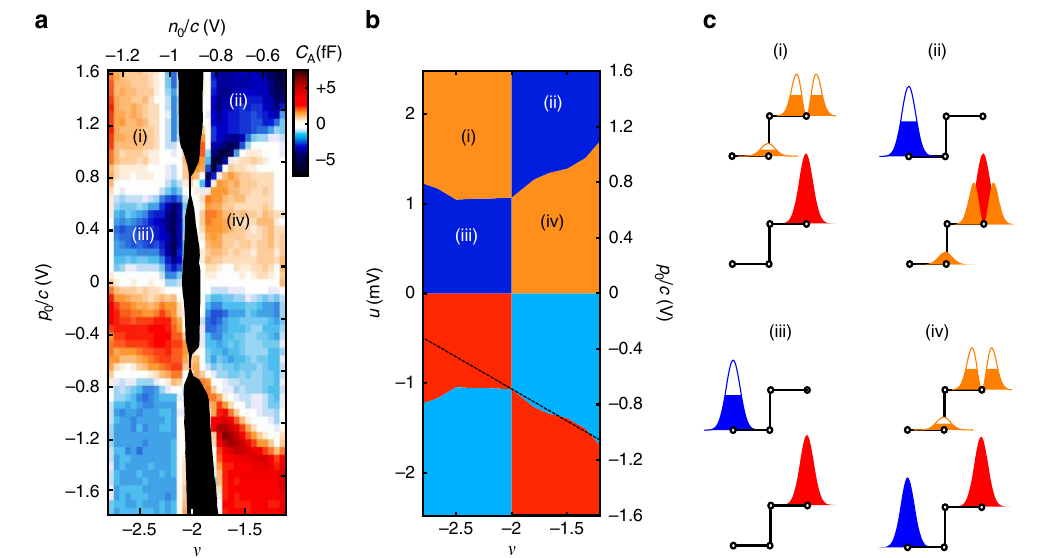
Fig. 4 Correlation effects at partial LL fi lling. a Detail of C A near ν = − 2. Sign changes in C A as a function of n 0 indicate polarization extrema and phase transitions. The strong dependence of the phase transition lines on ν are a consequence of interactions, which cause the energy per particle of the competing phases to depend on ν . b Phase diagram from multicomponent in fi nite DMRG calculations 31 for a four-band model of bilayer graphene with Coulomb interactions. In contrast to the Hartree-Fock prediction shown in Fig. 3c, experiments show that the magnitude of the slope of the phase boundary between (i) and (iii) differs from the boundary betweem (ii) and (iv). This implies that strong scattering between the N = 0, 1 orbitals breaks the particle- hole symmetry ν ↔ − ( ν + 2), an effect which is correctly accounted for in our DMRG simulations. c Schematic representation of the four phases appearing in a . Each of the four orbital types ξ N depicted in Fig. 2c can either be fi lled ( solid , shown in bottom unit cell ), or in the process of fi lling ( partially solid , shown in top unit cell ). Phase (ii), for example, consists of fully fi lled þ 0